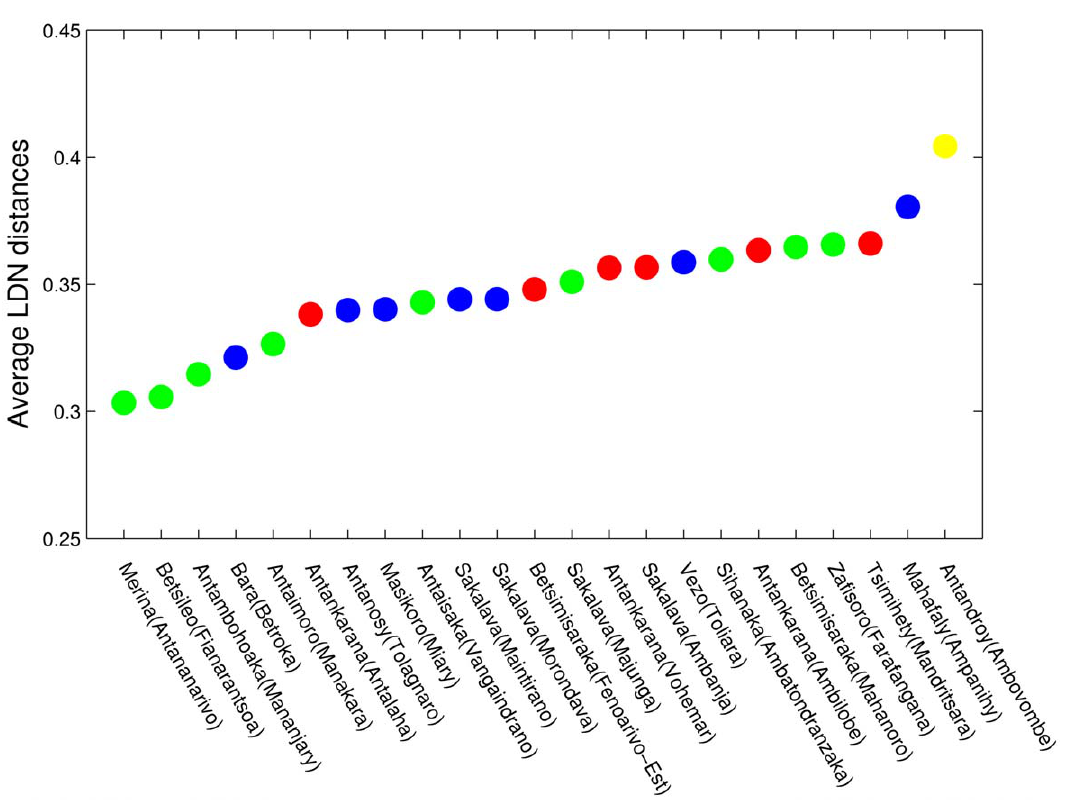
Figure 3. Average distance of the Malagasy dialects from all the others. The 23 dialects are colored as in Fig. 2. Highlands dialects (Antananarivo, Fianarantsoa and Betroka) together with south-east coast dialects (Mananjary and Manakara) show the smallest average distance.